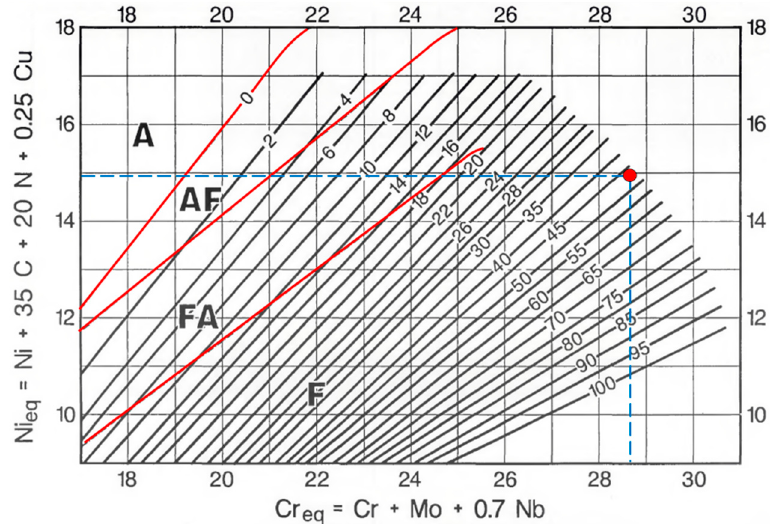
Figure 10. Nomenclature of solidification modes in stainless steels. Adapted from [46]. The wire composition is represented by the red circle marker based on the Cr and Ni equivalents adopted by WRC-1992 (Equation (2)).